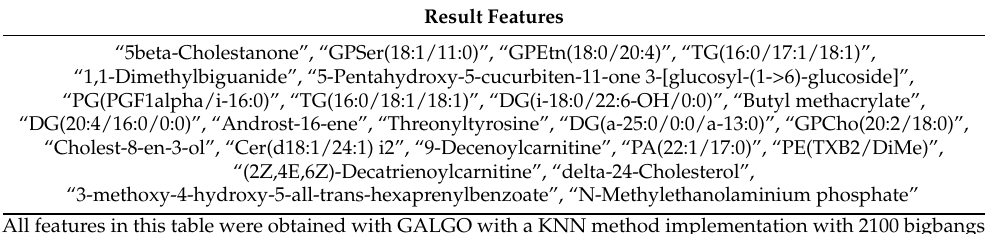
Figure 10. Evolution of maximum fitness scores over generations, using the Prediabetes-T2DM dataset. The vertical axis represents the fitness score, while the horizontal axis represents a given gen- eration. The solid blue line represents the average fitness across all models. The average unfinished fitness plotted as a solid cyan line represents the average worst case expectation for all failed searches in a given generation. The red dotted line shows the established GA goal fitness. Table 9. Features obtained by the GALGO KNN method in the Control-DN